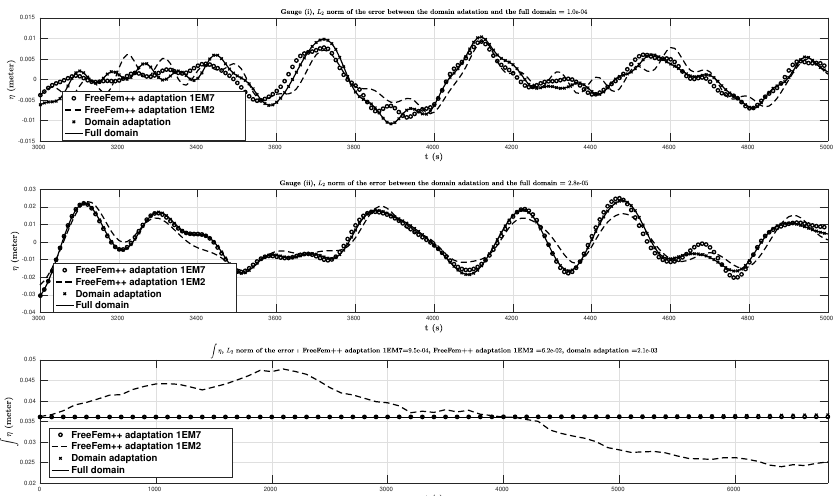
Figure 11. Comparison between the three methods: full, FreeFem++ adaption with err = 10 − 2 and err = 10 − 7 and the domain adaptation of the free surface elevations (in meters) vs. time (in seconds), computed numerically at two wave gauges (up and middle) and of the mass conservation (down).